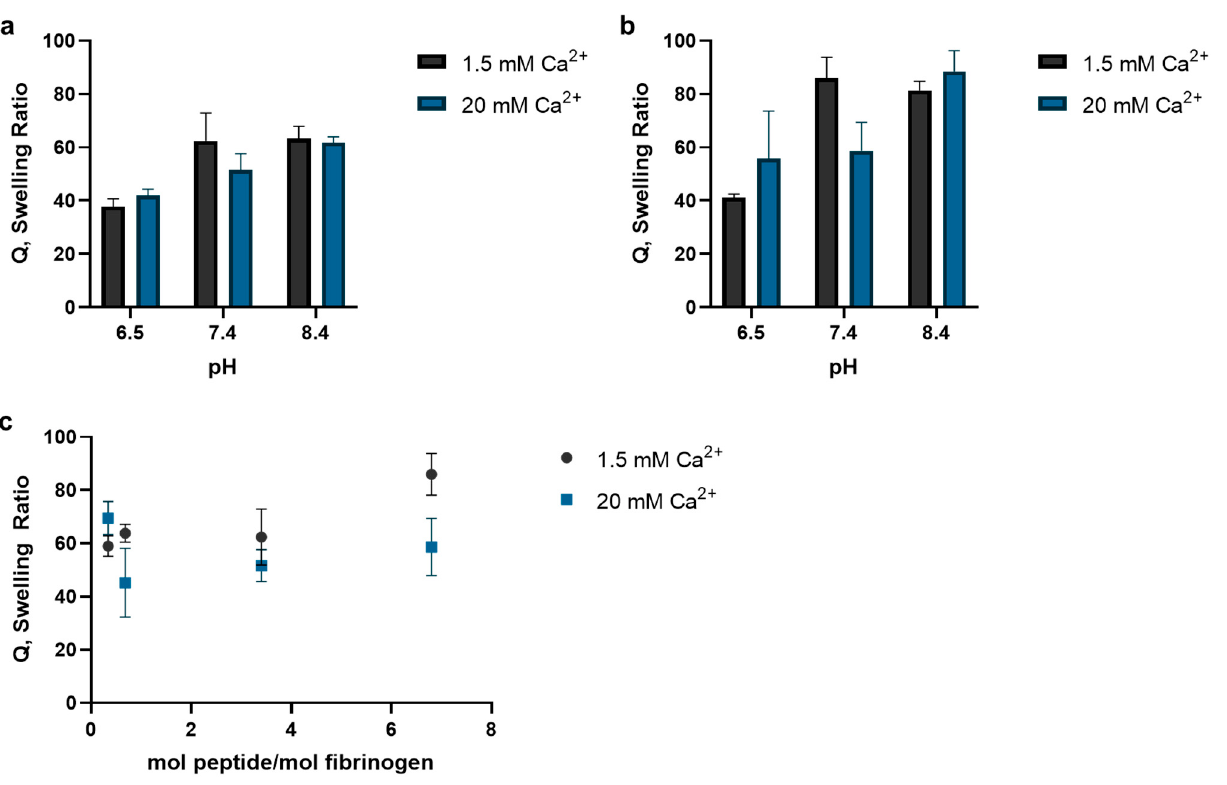
Figure 3. The pH-dependent mass swelling ratio (Q) of fibrin hydrogels following alpha 2-plasmin inhibitor peptide incorporation into fibrin hydrogels prepared with ( a ) 3.4 and ( b ) 6.8 mole ratio between alpha 2-plasmin inhibitor peptide and fibrinogen. Increasing the pH of the fibrin polymerization reaction increased Q, while there was a decreasing trend in Q with increasing Ca 2+ concentration in the reaction. ( c ) Holding the pH constant at 7.4 and increasing the ratio between alpha 2-plasmin inhibitor peptide and fibrinogen increased the mass swelling ratio. For all conditions, the fibrin hydrogels were prepared with 2 IU/mL thrombin and incubated at 37 °C for 30 min to allow the fibrin hydrogels to polymerize ( n = 3).